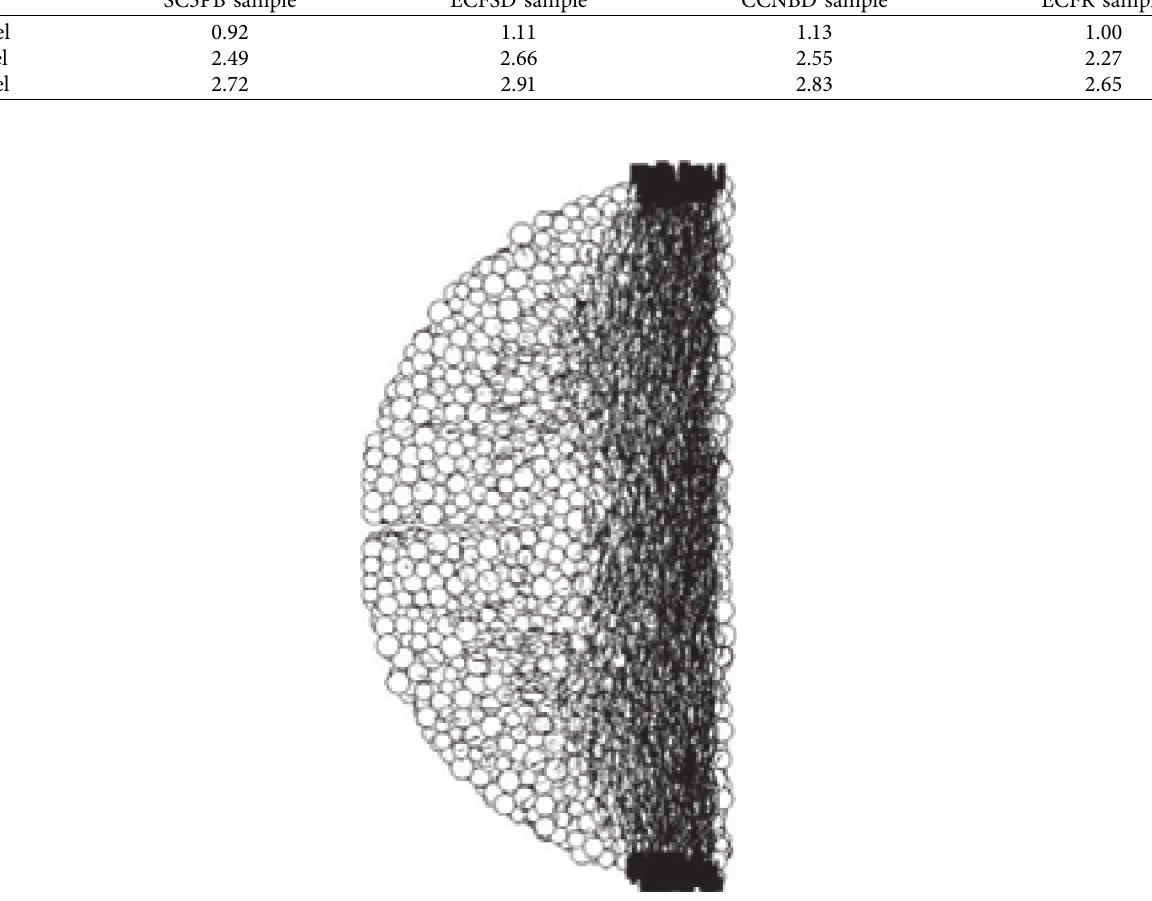
Figure 28: Contact force between particles in the ECFSD